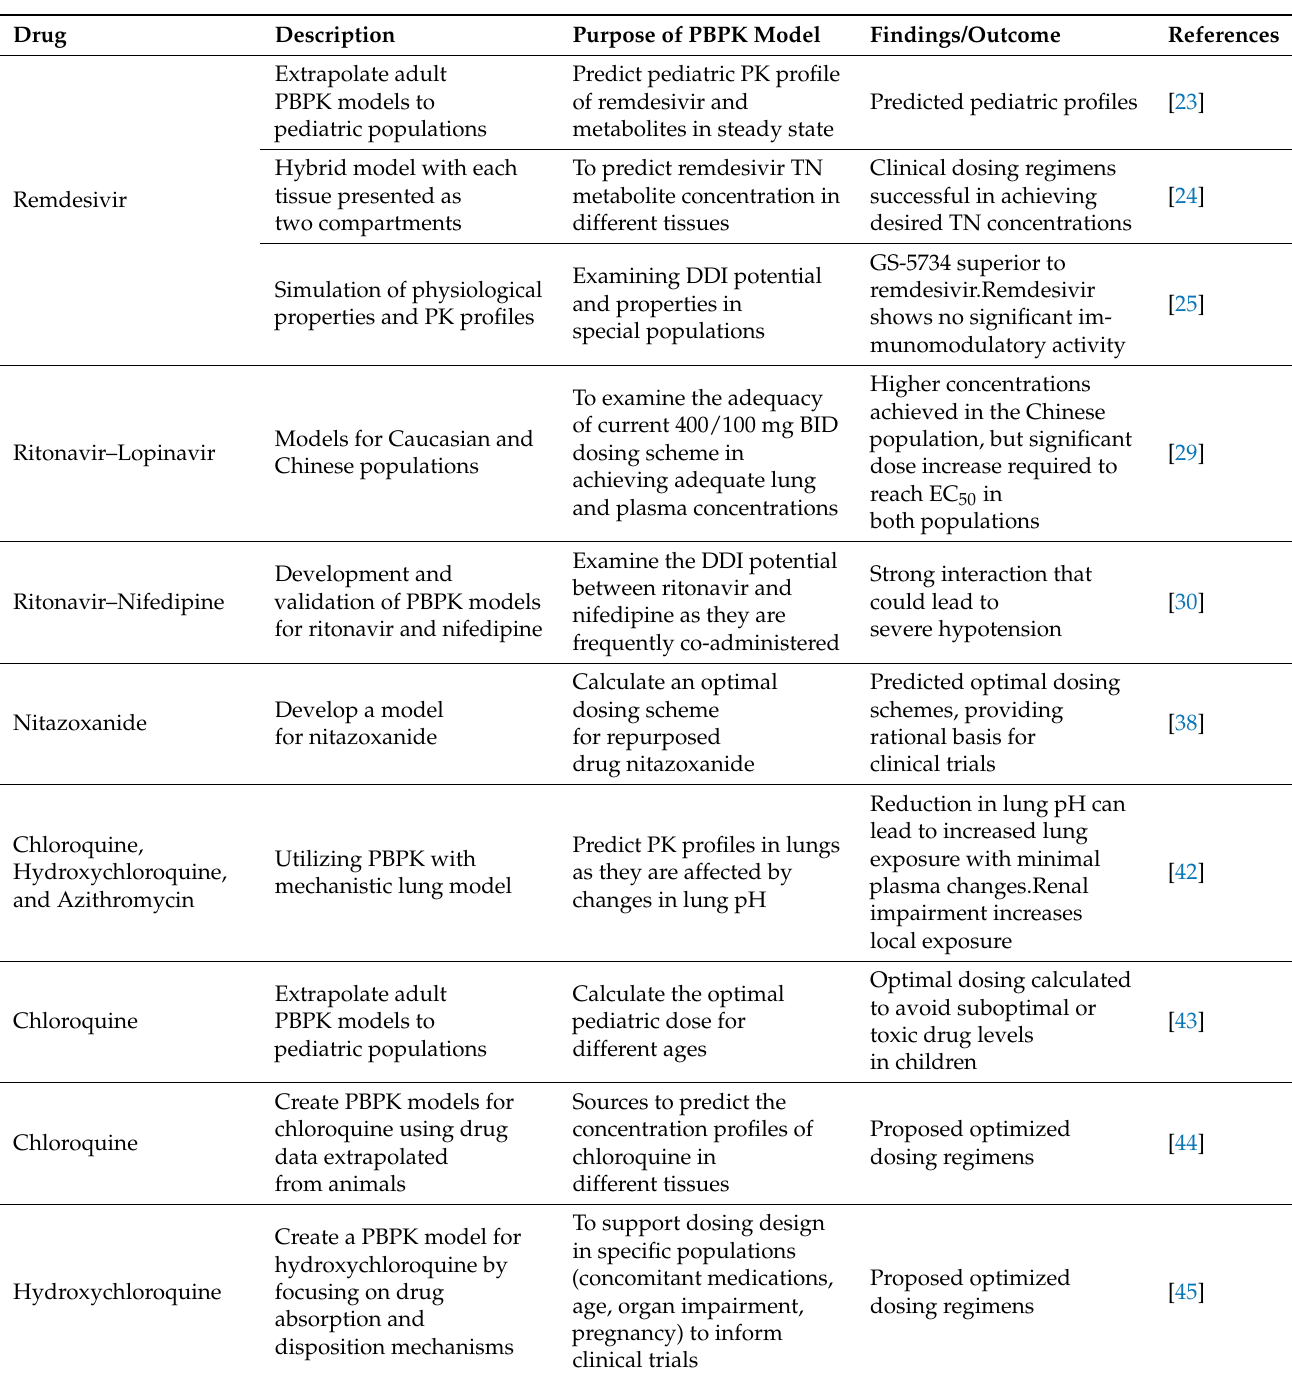
Table 2. Application of PBPK in repurposing COVID-19